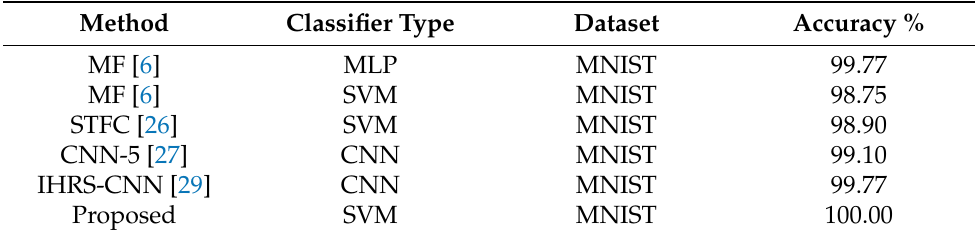
Table 3. Comparison between the proposed method and the state-of-the-art methods based on Roman numeral recognition in clean environment.